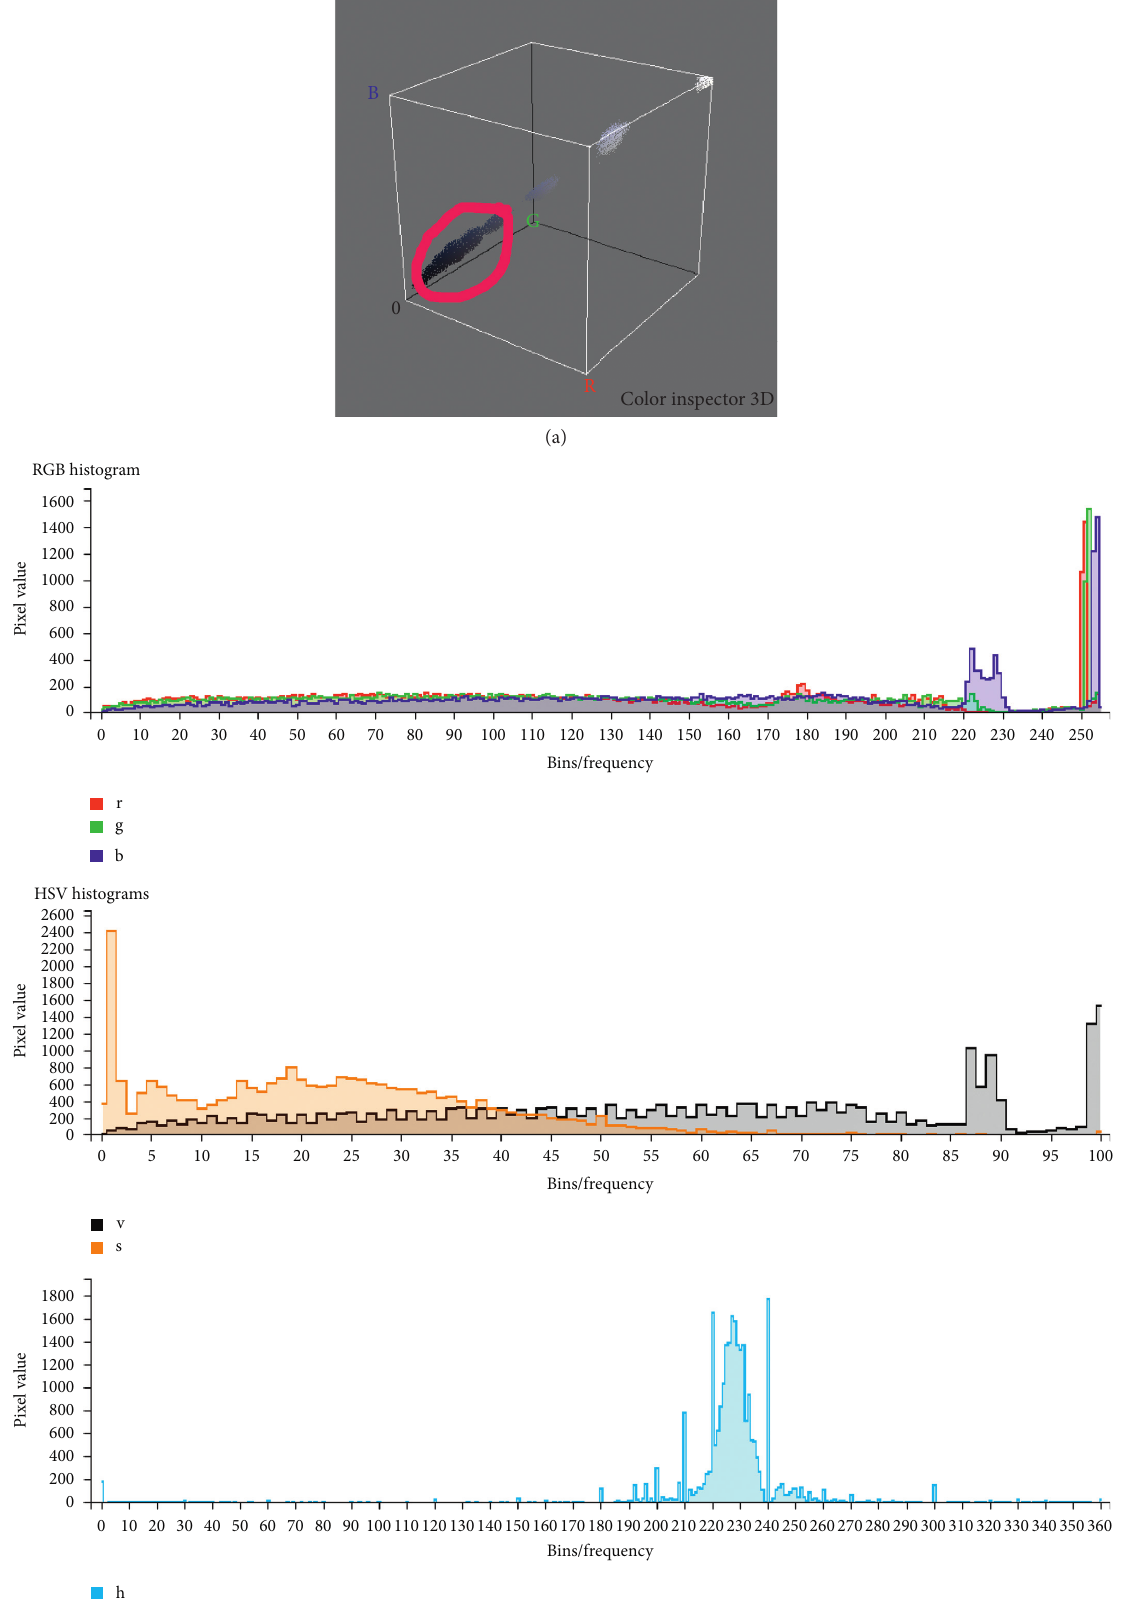
Figure 14: (a) RGB color model; (b) histogram for RGB and HSV color